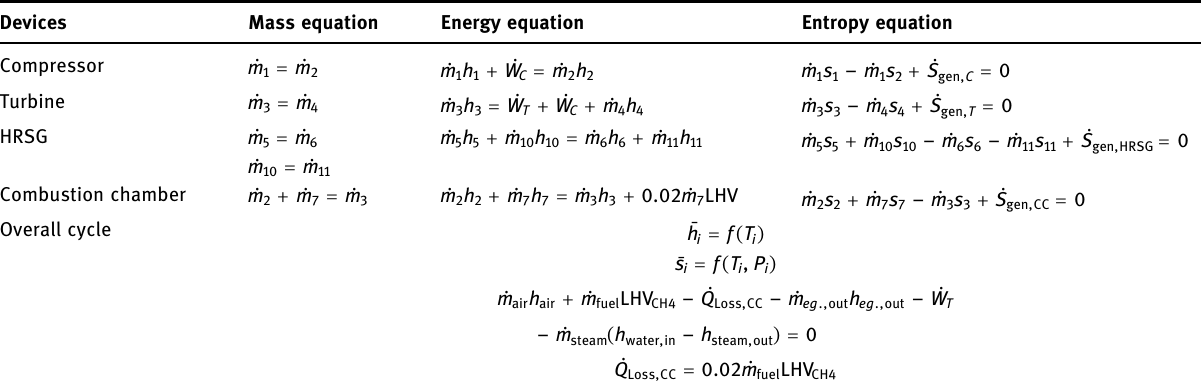
Table 1: Energy, entropy, and mass equations of the apparatus of the ab system [ 5,7,30,32 ]